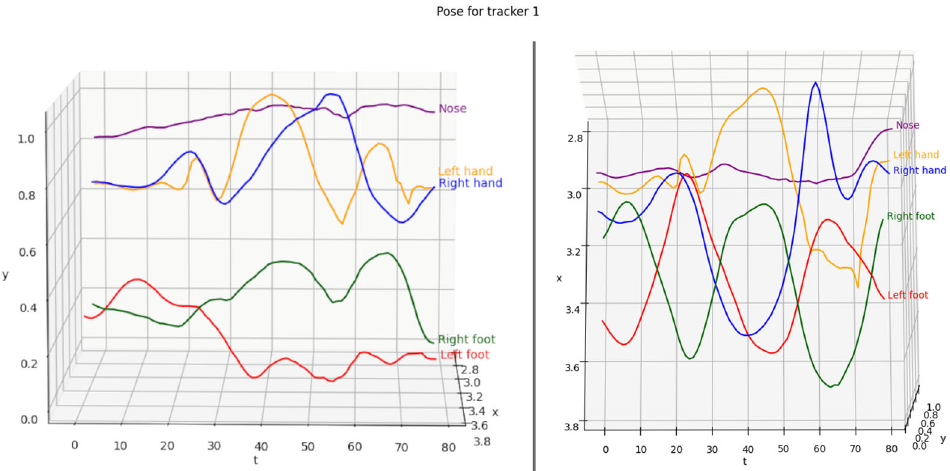
Figure 11. A 3D plot visualization of the 2D sequence joints in space and time when executing a jump shot, showing a side and top view of the plot. shot, showing a side and top view of the